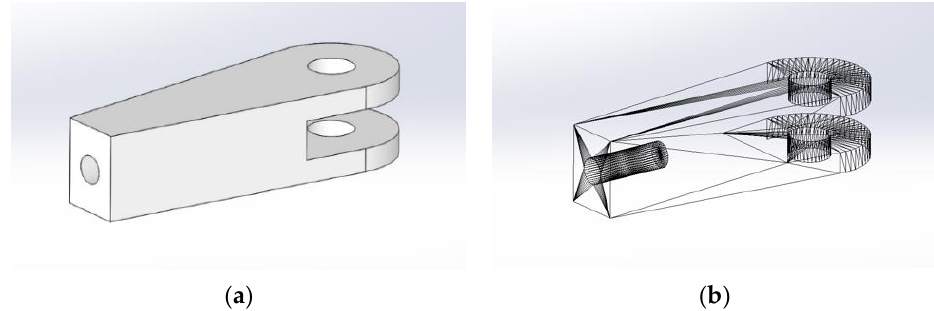
Figure 4. Servo motor crank knee-arm: ( a ) Visualization in SolidWorks; ( b ) SolidWorks mesh model.